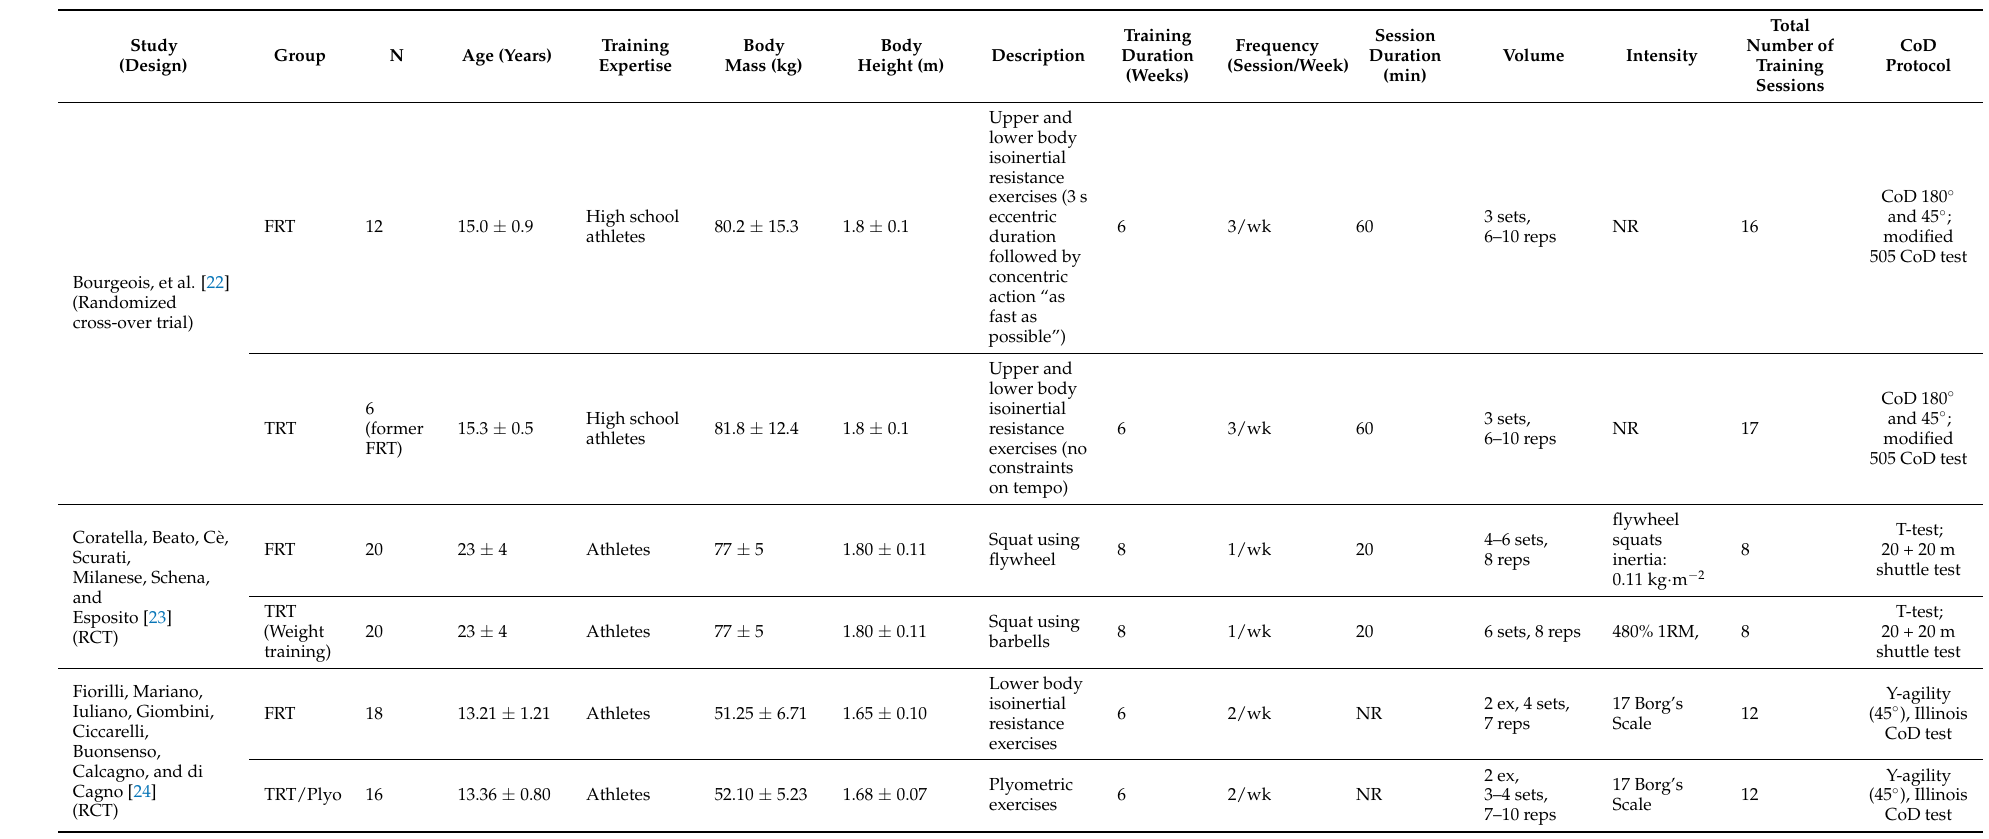
Table 2. Characteristics of the included